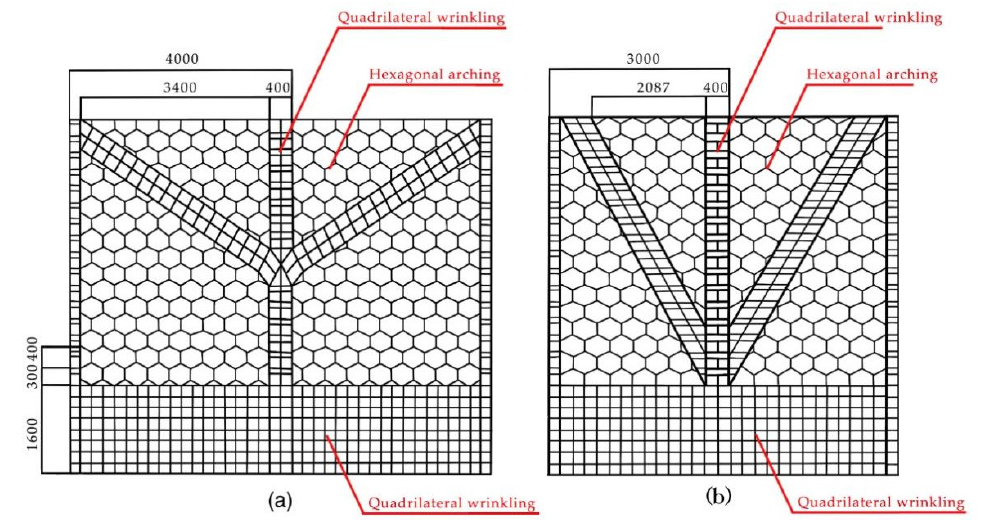
Figure 2. Two types of floor plans based on the characteristics of dragonfly wing mesh structure. ( a ) shows the grid plan of carport I, ( b ) shows the grid plan of carport II.